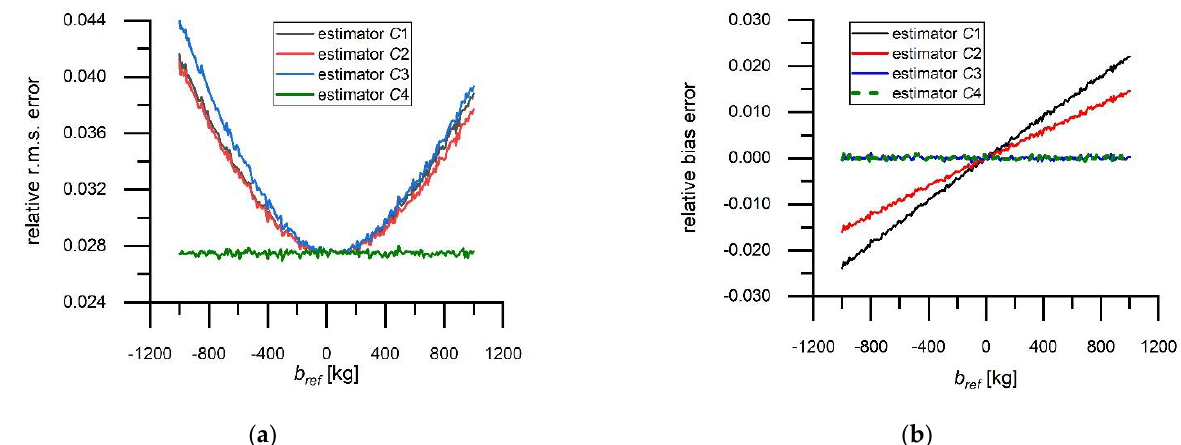
Figure 2. Influence of the WIM static characteristic shift on: ( a ) relative r.m.s. errors and ( b ) relative bias error of weighing, C ref = 1.